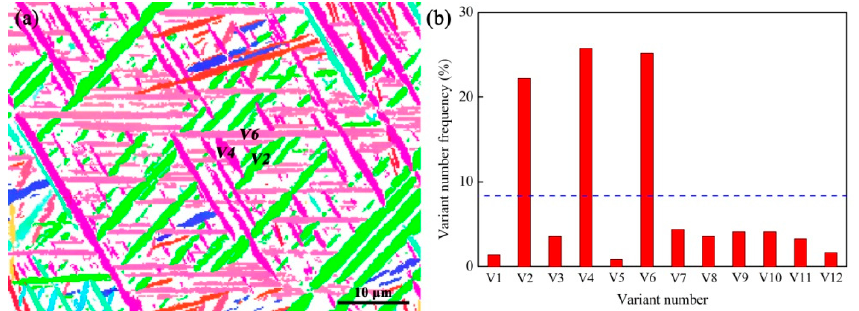
Figure 6. ( a ) The local inverse pole figure map shows that there is only one triangular configuration constituted by three α 2 ′ variants V2, V4 and V6. ( b ) Histogram of the number frequency for the twelve variants in the map. Note that V2, V4 and V6 are predominant.